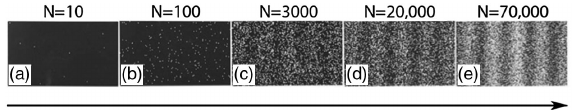
FIG. 1. Buildup of an electron interference pattern.